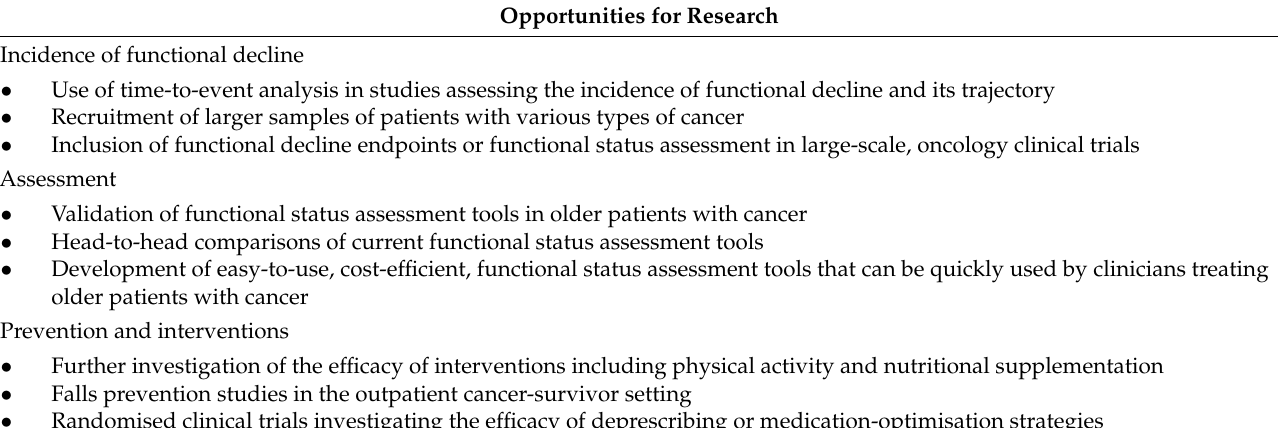
Table 3. Future directions for research in relation to cancer and functional